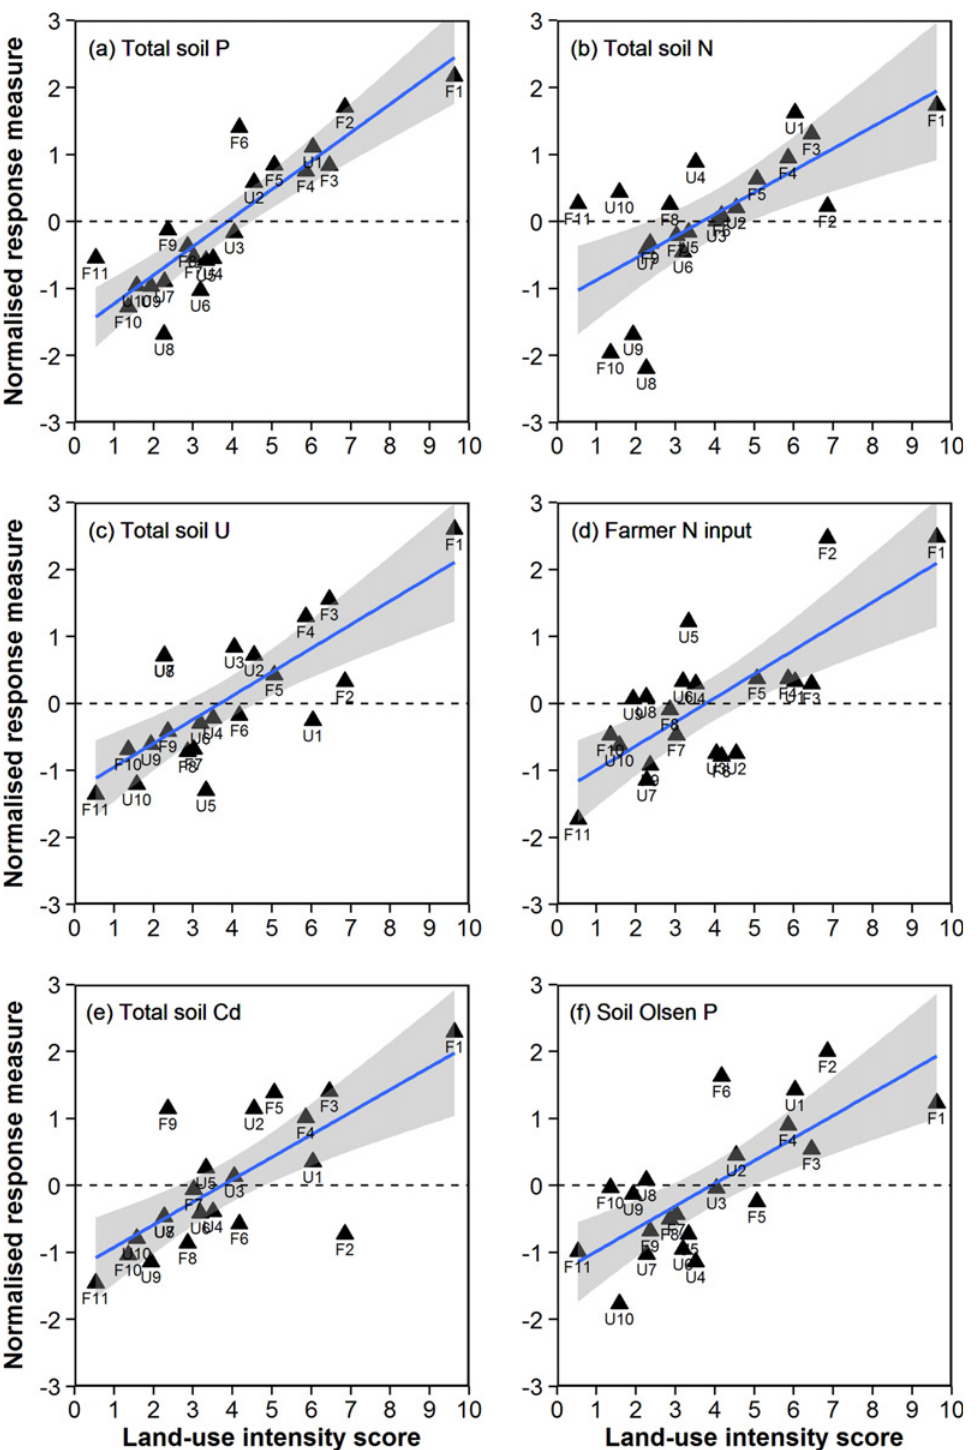
Figure 3. Relationships between the composite PCA axis 1 measure of land-use intensity (see Fig. 2) and the six component variables with the highest factor loadings (S5 Table, S2 Fig.), including both soil biogeochemistry and farmer input measures.